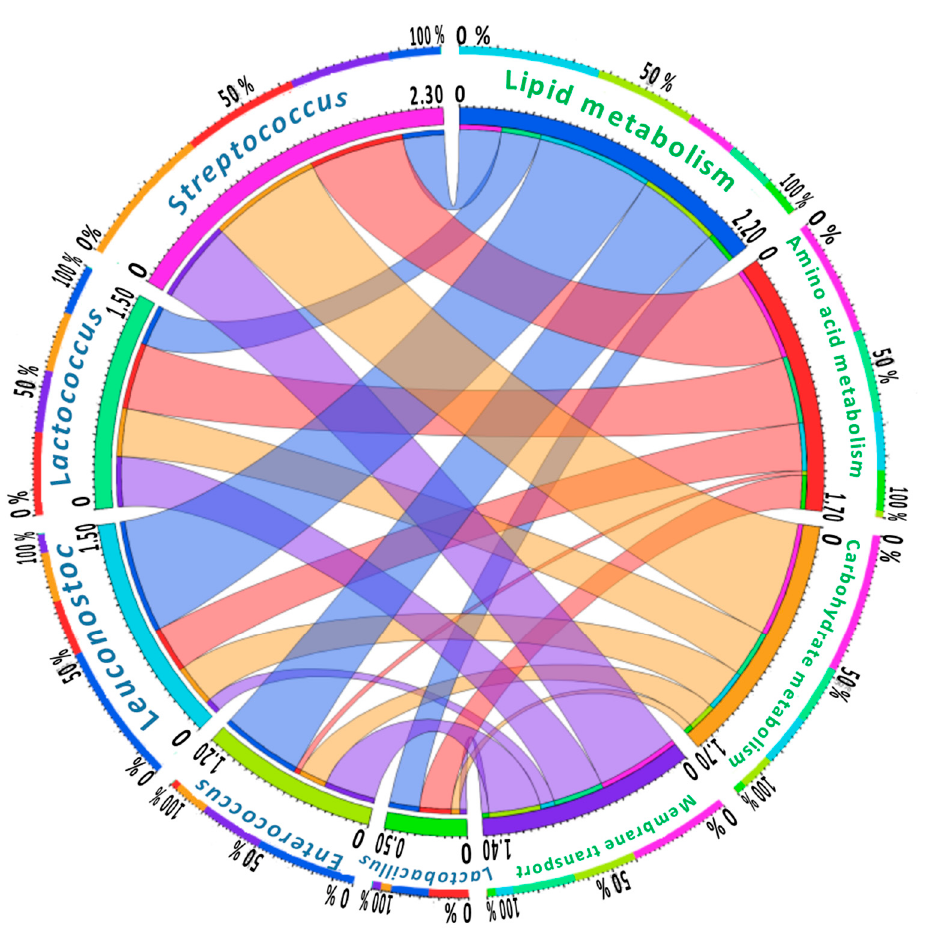
Figure 5. Schematic representation of Pearson’s correlations among relative abundance of main genera of core bacteria and relative frequencies of KEGG predicted genes associated with metabolic pathways at level two in artisanal Adobera cheese samples. Stronger correlation scores are represented by thicker bonds (Created with: Circos Table Viewer v0.63-9).